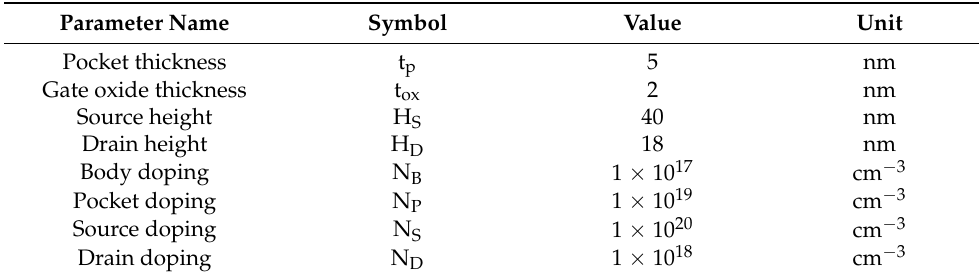
Figure 2. BTBT tunneling generation of ( a ) TGTFET and ( b ) DGTFET at on state. Table 1. Device parameters used for the simulation.